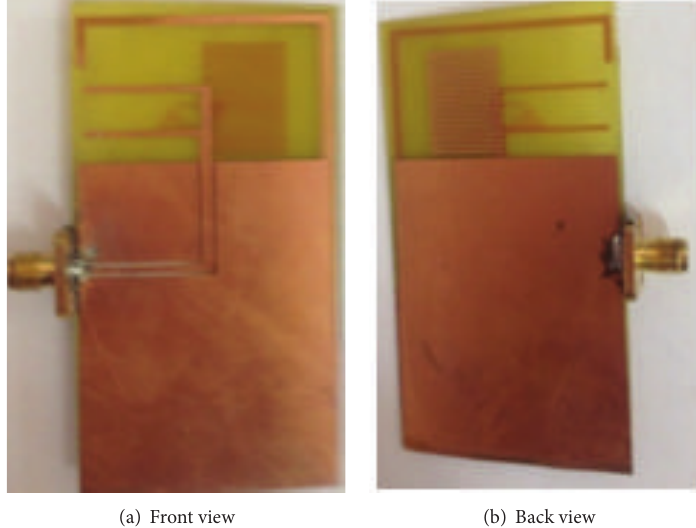
Figure 2: Prototype of the proposed antenna: (a) front view and (b) back